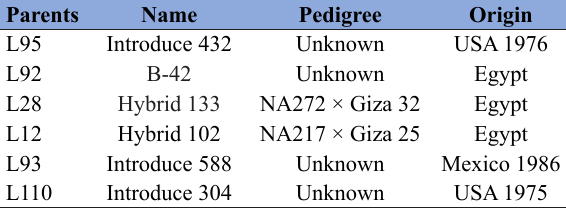
Table 1 . Name, pedigree and origin of sesame parental genotypes